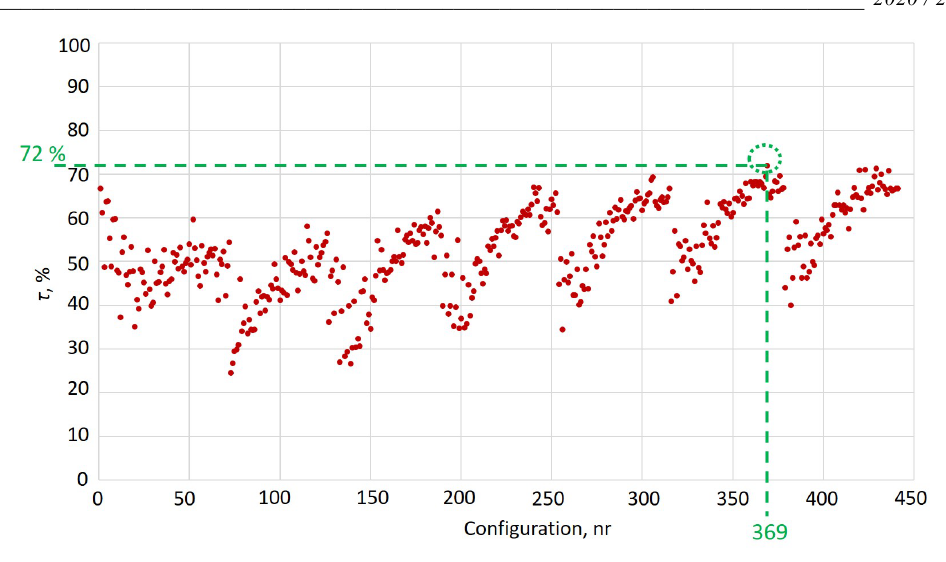
Fig. 7. Correlation between technical benefit score and configuration number using five criteria. Best scenario is indicated in dotted cycle: τ MAX = 72 % for configuration nr. 369, i.e. α1 = 75°, α2 = 75°, h1 = 3.8 m, h2 = 3.8